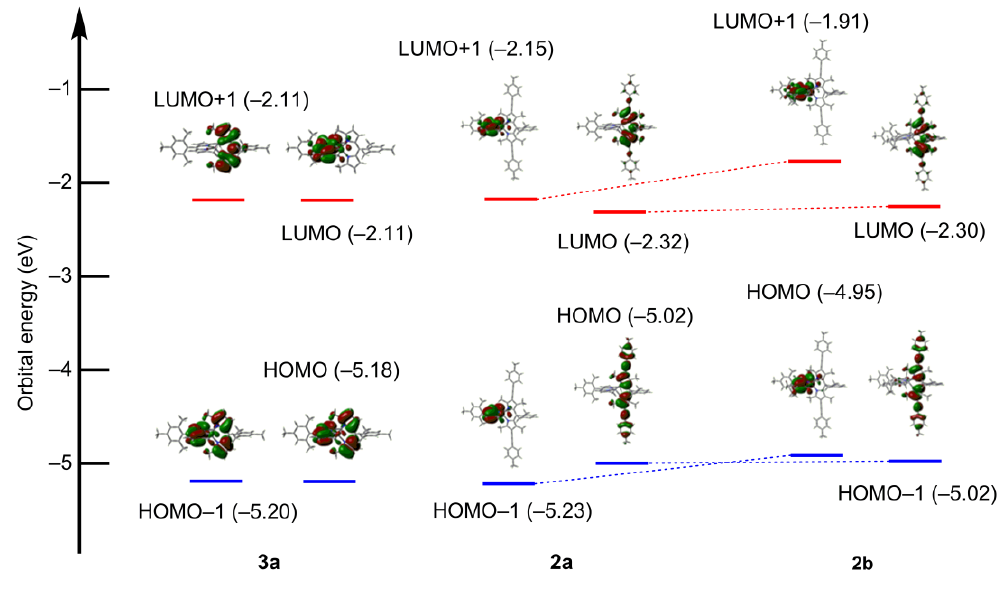
Figure 20. Frontier orbitals of 3a (left), 2a (middle), and 2b (right), calculated using the B3LYP/6-31G(d) level of theory, considering CH